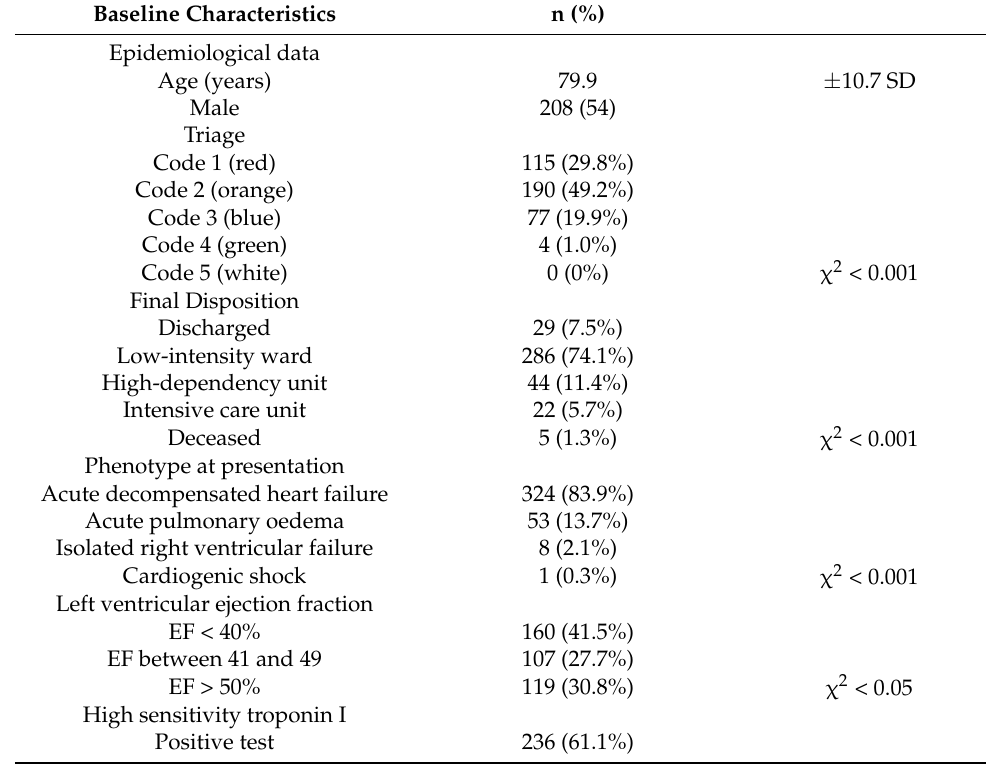
Table 1. Patient’s characteristics (n.386).